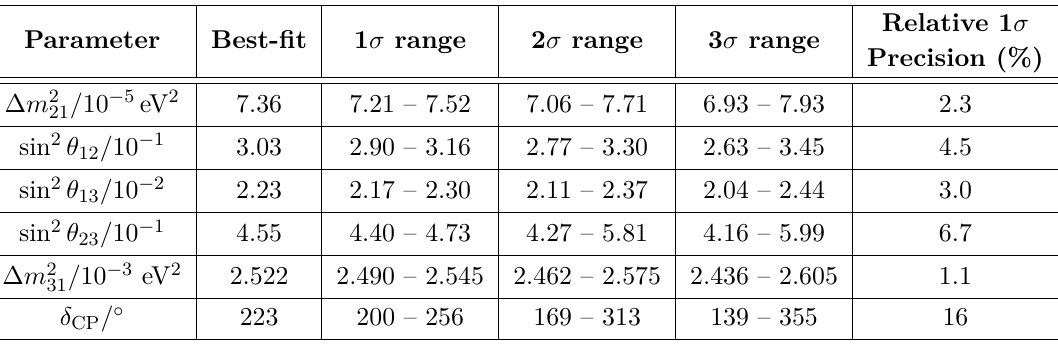
Table 1 . The benchmark values of the oscilation parameters and their corresponding ranges that we consider in our study assuming NMO. In second column, we mention the best-fit values as given in ref. [11]. The third, fourth, and fifth columns depict the current 1 σ , 2 σ , and 3 σ allowed ranges, respectively under NMO scheme. The sixth column depicts the present relative 1 σ precision on various oscillation parameters as given in ref.